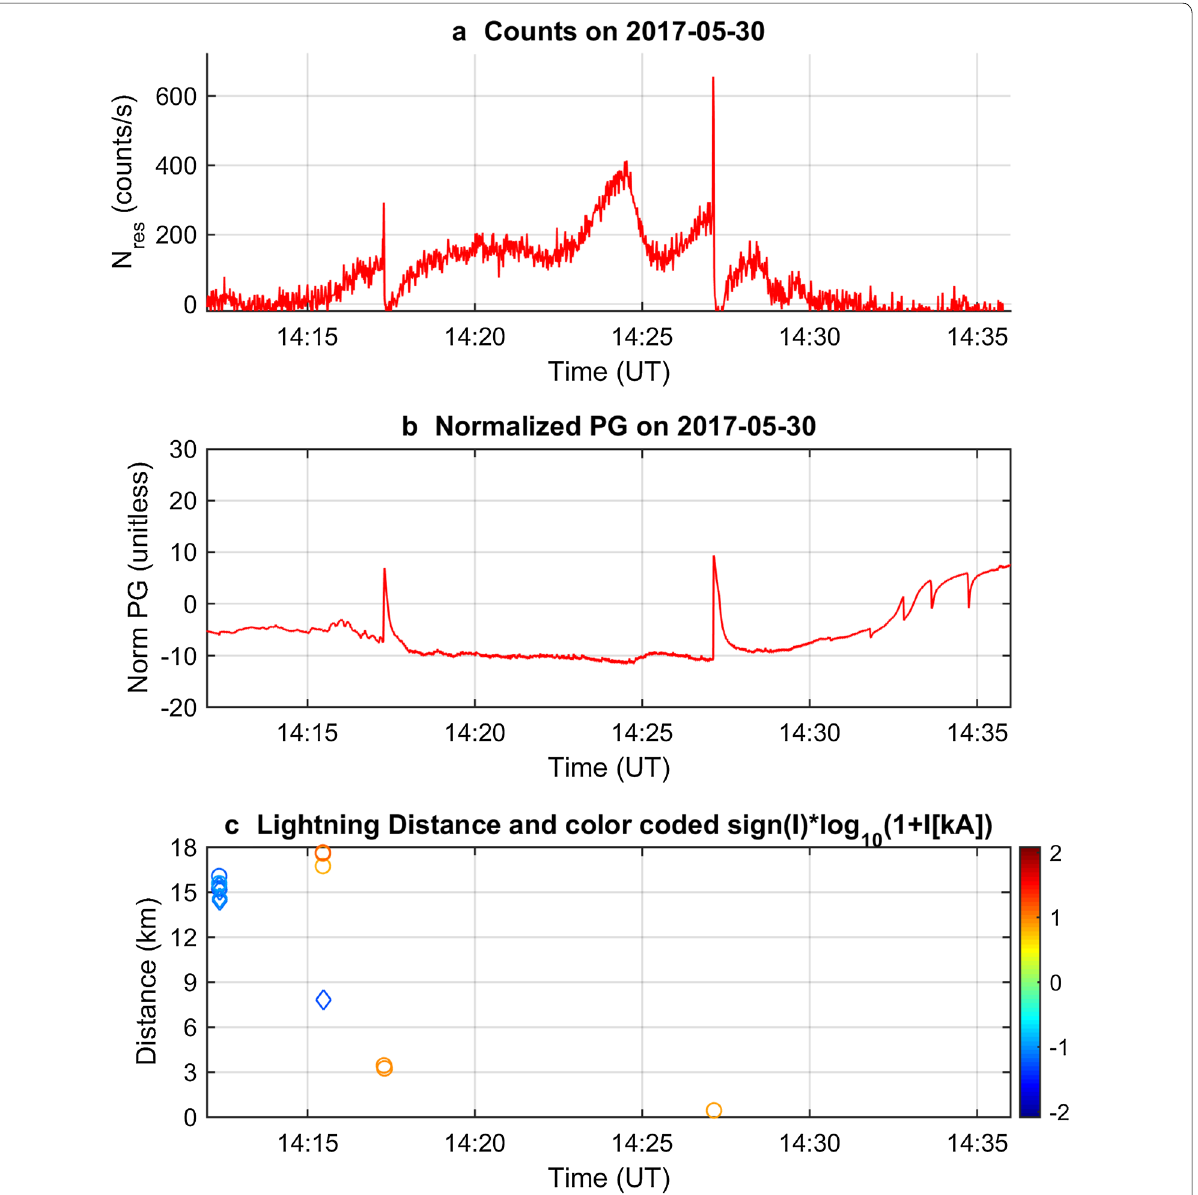
Fig. 8 Event recorded on 30 May 2018 around 14:24 UT. a residual counts at Lomnicky peak by red. b Normalized PG at Lomnicky peak (red). c Lightning distances from Lomnicky peak as recorded by EUCLID lightning detection network; CG discharges are by diamonds, IC by circles, peak current I is color-coded; the color approximately corresponds to the common logarithm of the peak current in kA, sign of the current